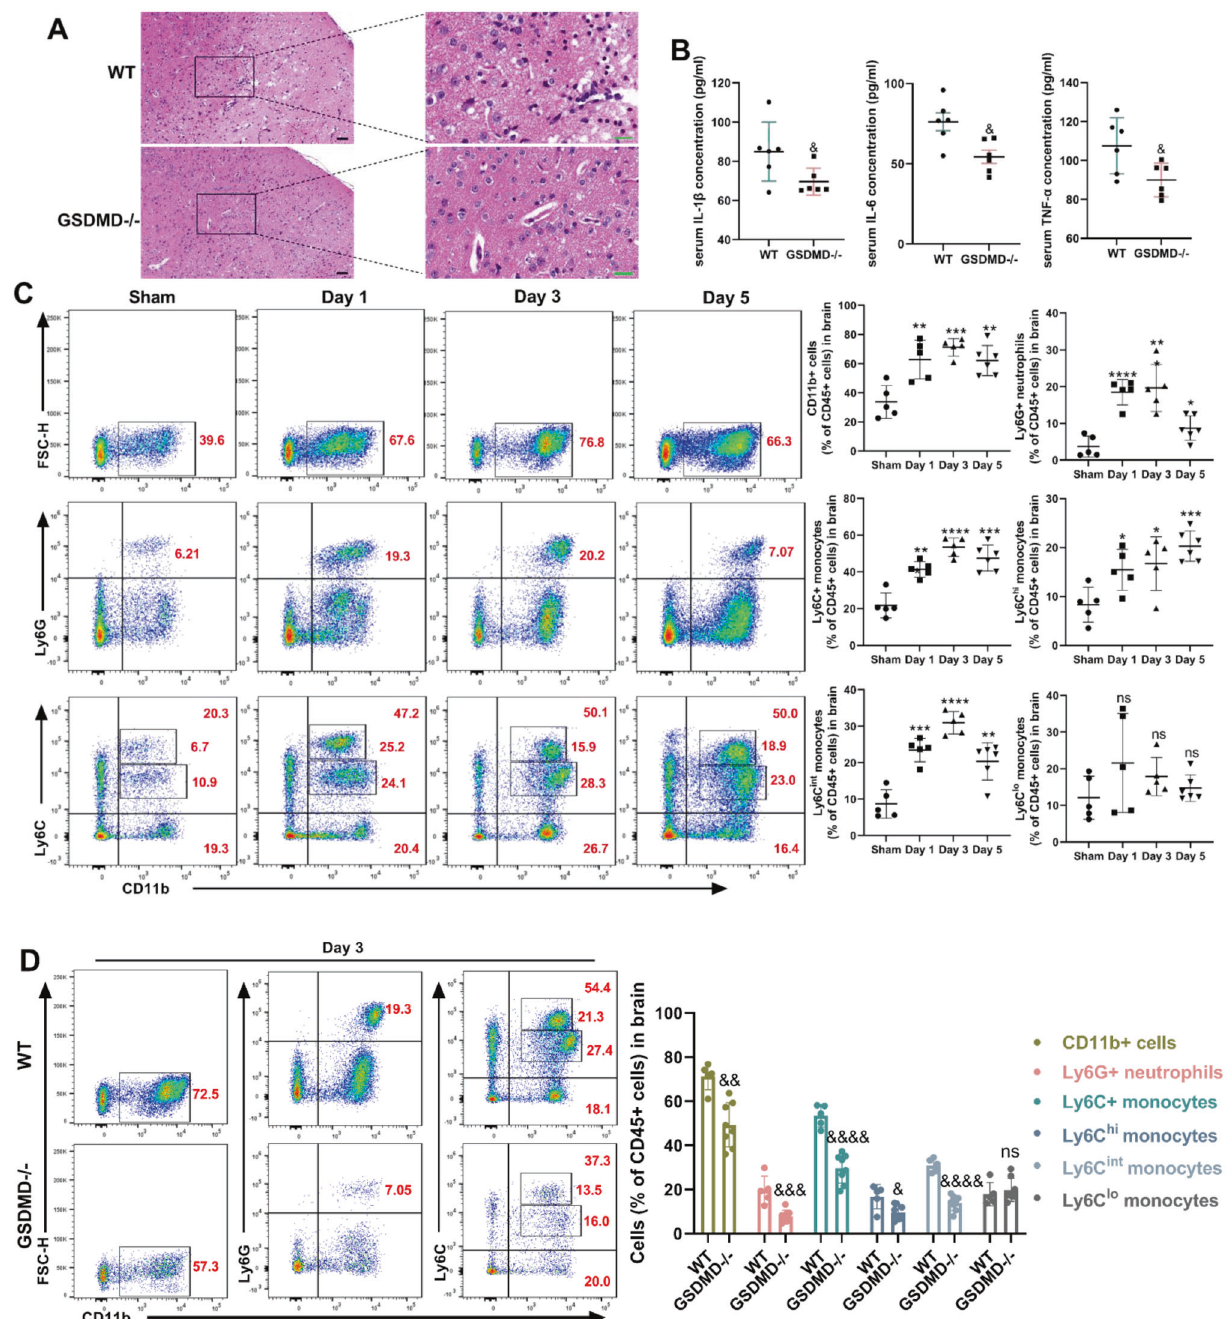
Fig. 3 GSDMD is required for the increase in neutrophils in the brain after MCAO in mice. A HE-stained coronal section shows the peri- infarct cortical areas at 3 days after stroke in GSDMD − / − mice compared with WT mice. Black bar = 50 μ m. Green bar = 20 μ m. B Quanti fi cation of serum IL-1 β , IL-6 and TNF- α levels in MCAO mice compared with sham-operated mice ( n = 6). Flow cytometric gating and quanti fi cation of brain leucocytes in ( C ) MCAO-operated mice vs sham-operated mice ( n = 5) and ( D ) GSDMD − / − mice ( n = 5) vs WT mice ( n = 8) after MCAO. The numbers inside/next to the gates indicate population frequencies (%). The data are presented as the mean ± SD. Statistical analysis: two-tailed unpaired Student ’ s t test ( B ) or One-way analysis of variance followed by Bonferroni ’ s multiple comparison test ( C ) or multiple two-tailed unpaired Student ’ s t test ( D ). ns not signi fi cant, * P < 0.05, ** P < 0.01, *** P < 0.001, **** P < 0.0001 vs sham-operated mice. & P < 0.05, && P < 0.01, &&& P < 0.001, &&&& P < 0.001 vs WT mice after blood of WT and GSDMD − / − mice 1 day after MCAO. The heat map displayed the top 30 genes that expression was drastically reduced in neutrophils by GSDMD knockdown. In addition to GSDMD, relevant genes were associated with thrombosis, the interferon signaling pathway, cytokine expression, cell survival, and in fl ammatory response (Fig. 5D). Kyoto encyclopedia of